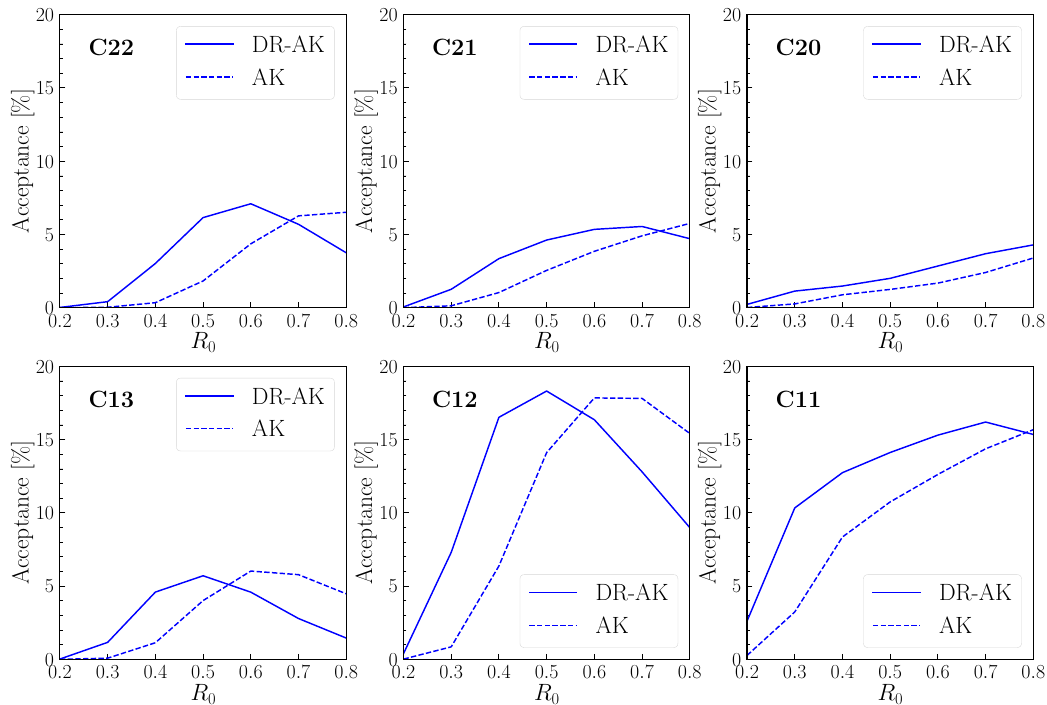
Figure 12 . The variation of A [eq. (3.1)] as a function of initial radius R 0 for six categories, namely C22, C21, C20, C13, C12, and C11. The solid blue lines are for the DR-AK algorithm, and the dashed lines are for the AK algorithm. The jets are clustered with R